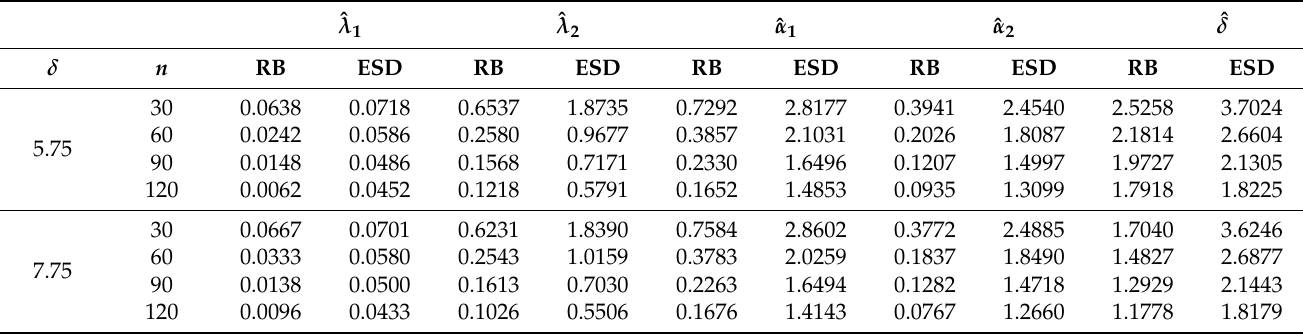
Table 3. RB and ESD for the BSHPN regression